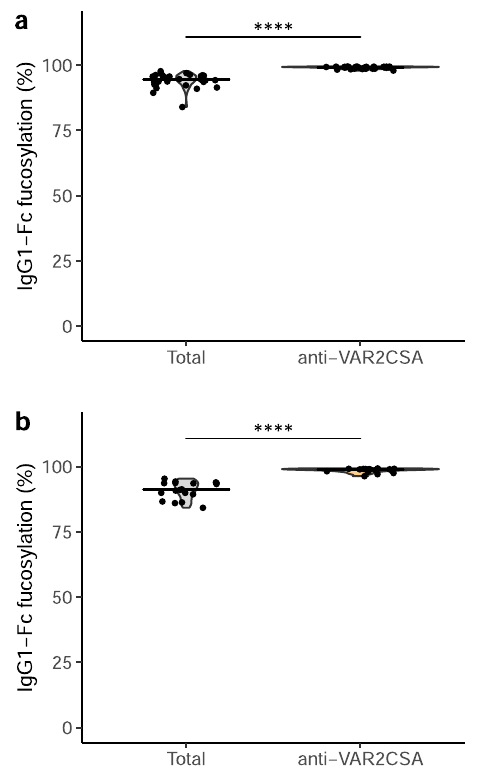
Fig. 4 VAR2CSA-speci fi c IgG induced by subunit vaccination is not Fc afucosylated. Fc fucosylation levels of total (gray) and VAR2CSA-speci fi c (orange) plasma IgG1 in German vaccinees ( n = 32) without ( a ) and in Beninese vaccinees ( n = 18) with ( b ) natural exposure to P. falciparum . Medians and densities are shown. Statistically signi fi cant pairwise differences between antigen-speci fi c IgG and total IgG (two-sided Wilcoxon signed-rank test) are indicated (**** P <